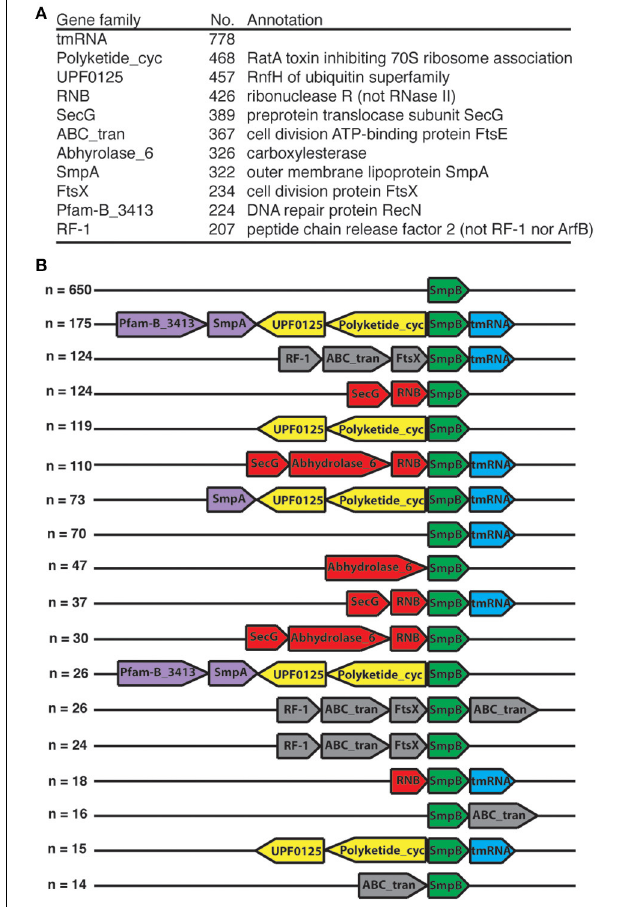
FIGURE 1 | smpB gene neighborhoods. Each neighborhood ( n = 2012) in our bacterial complete genome set was taken as the 11-gene window centered at smpB . (A) Frequent neighbors. The tmRNA gene (the only RNA gene encountered) and Pfam families present in more than 200 smpB neighborhoods are listed with a representative annotation for the instances of each family. (B) Clusters. Each neighborhood was summarized as a cluster, considering only the families of (A) (note the more specific gene annotations there). The top clusters are shown with color coding of common